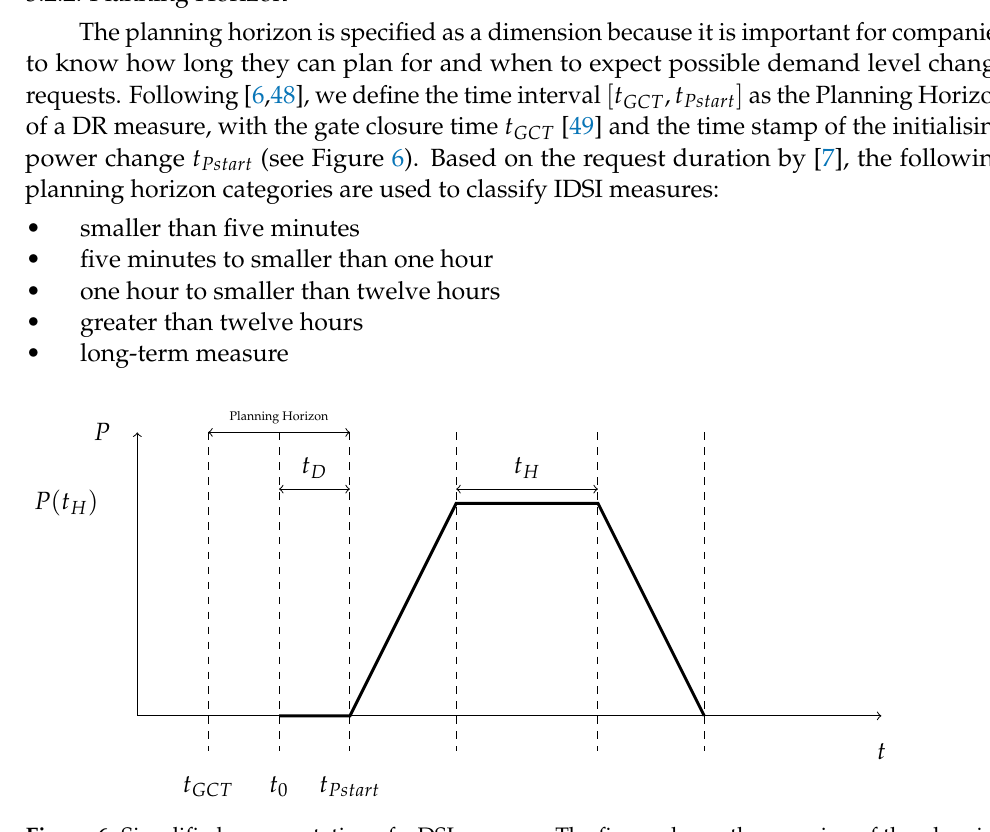
Figure 6. Simplified representation of a DSI measure. The figure shows the meaning of the planning horizon, which reaches from the gate closure time T GCT to the initialising power change t Pstart . Furthermore the reaction duration t D is a subset of the planning horizon between the time pulling the trigger at t 0 and the start of a DSI measure at t Pstart . In addition the holding duration t H is shown as the duration for which the DSI measure runs at its power states P ( t H )